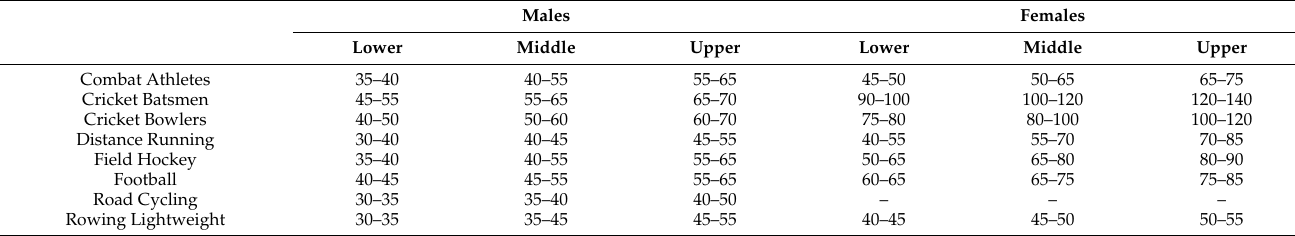
Table 5. Overview of Σ 8 skinfold ranges (mm) in a variety of sports (data compiled from personal communications with peers working in elite performance). Lower, middle and upper ranges suggested are based upon typical values measured in elite sport although it must be stressed that attributing performance to skinfold measures is difficult to establish. Males Females Lower Middle Upper Lower Middle Combat